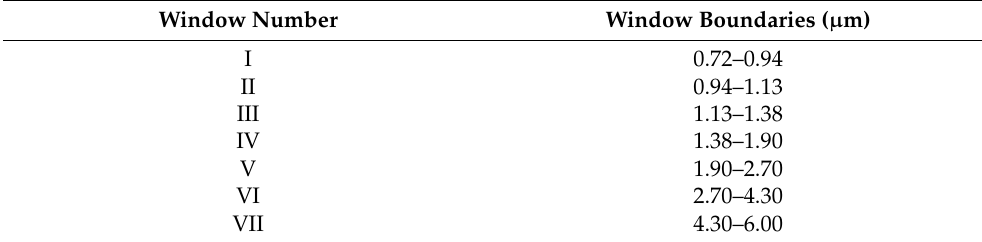
Figure 7. Absorption line strength of selected molecules from HITRAN 2012 database [29]. Table 3. Atmospheric windows wavelength upper and lower